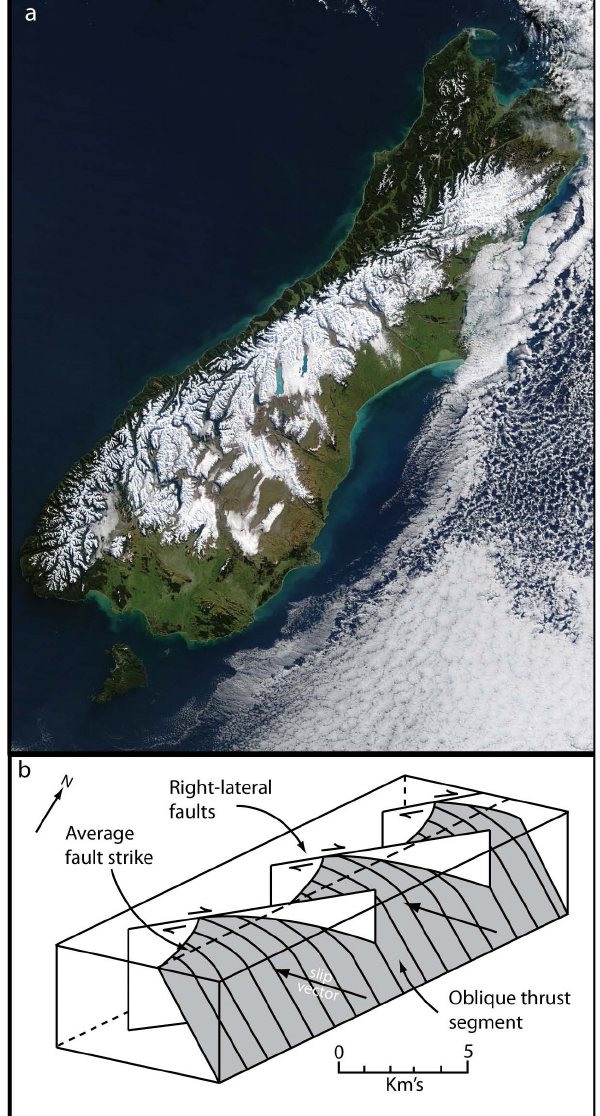
Fig. 2. (a) Satellite image of the South Island. The Alpine Fault can clearly be identified by the linear snow line on the Western edge of the Southern Alps; (b) simplified 3D model showing the complex segmentation of the Alpine Fault. Adapted from Norris and Cooper